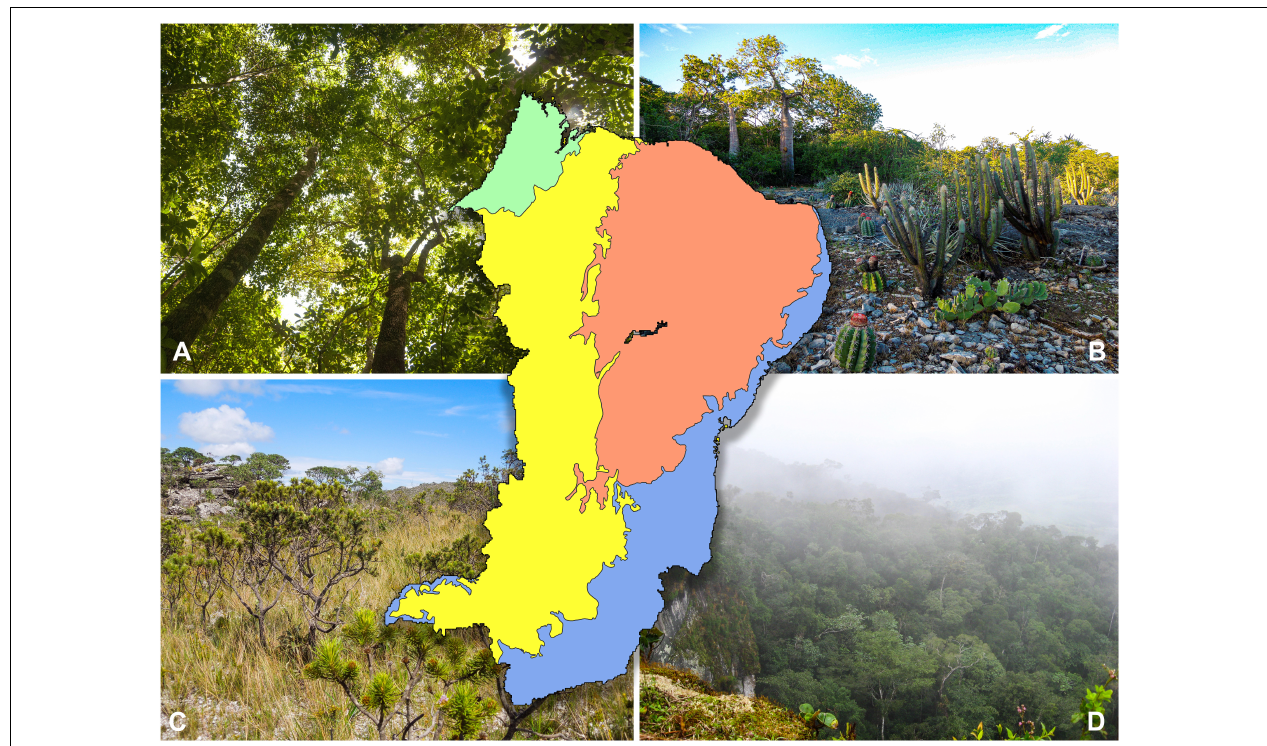
FIGURE 1 | The main biogeographical regions of northeast Brazil (including the state of Minas Gerais) where three biomes predominate: the geographically disjunct Amazonian and Atlantic rainforests [ (A) , green; (D) , blue], the succulent-rich Caatinga seasonally dry tropical forests [ (B) , red], and the grass-rich, fire-prone savannas of the Cerrado [ (C) , yellow]. For geographic reference, the whole north and northeastern borders of the inset are the Atlantic Ocean. Photos by PWM (A) and DC (B–D)